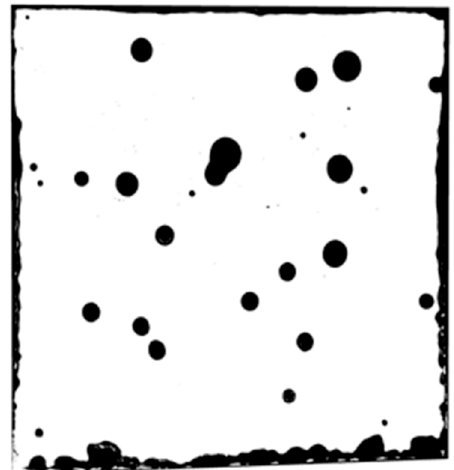
Figure 7. Binary image of Figure 8 to calculate the total corroded area.